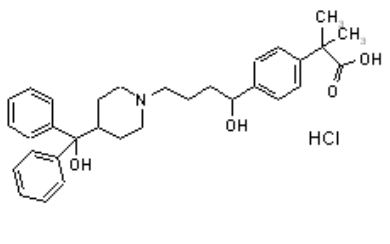
Figure 1. Structure of fexofenadine